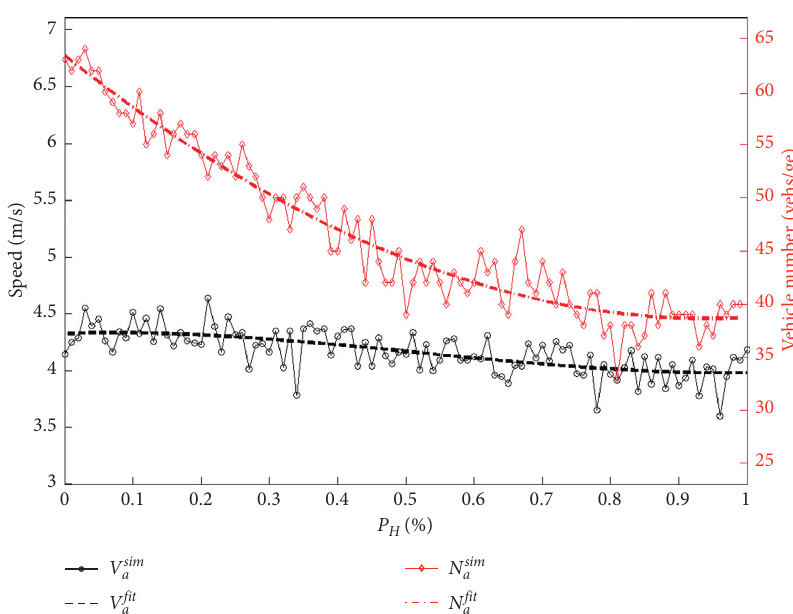
Figure 7: Diagrams under different P